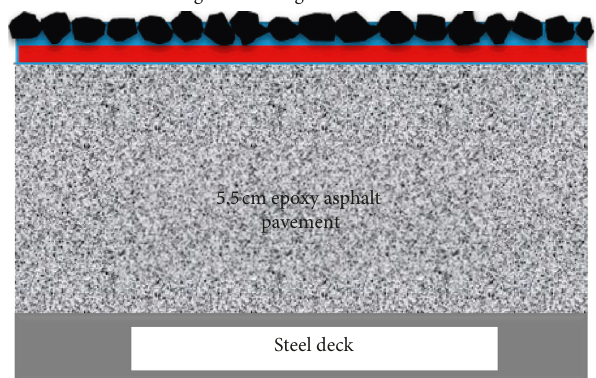
Figure 22: Structure of the thin overlay of fiber-reinforced